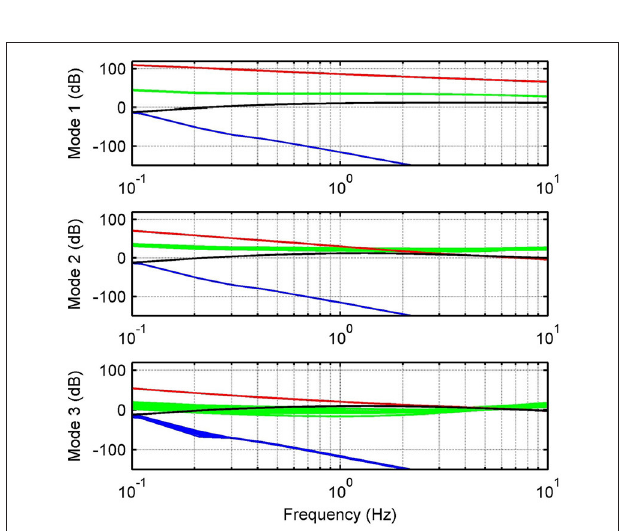
FIGURE 5 | Relative errors and upper bounds. Relative errors between nominal and uncertain models with respect to inputs u k (green) and r k (blue). Graphs also show upper bounds for inputs u k (red) and r k